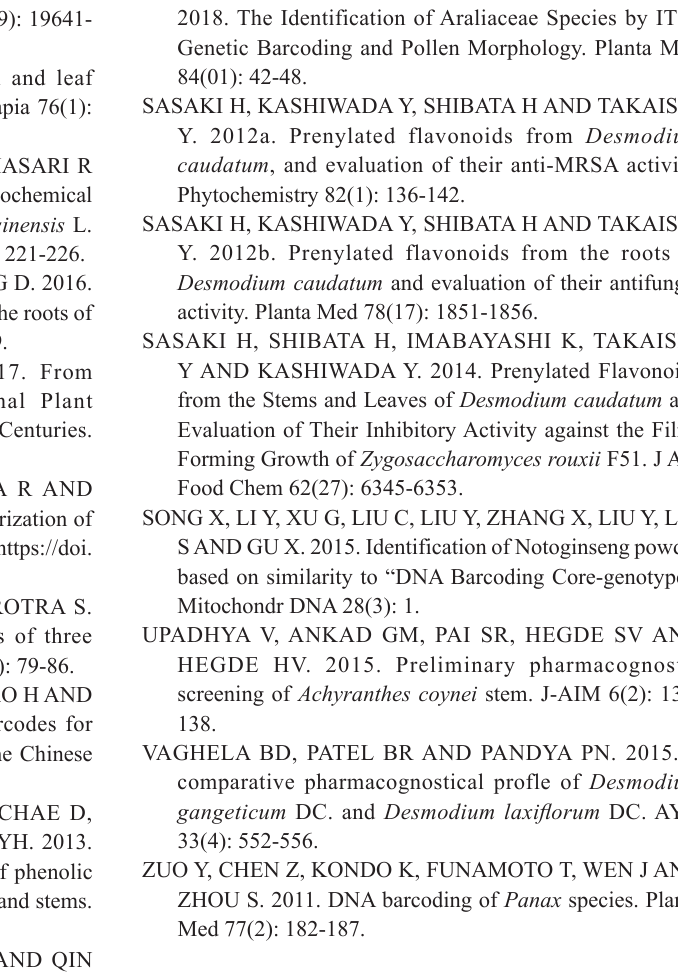
Figure S1 - Micrograph of leaf epidermis of Desmodium caudatum, A represents the upper epidermis, whereas B is the lower epidermis. Bars: A= 50 µm, B= 30 µm. Figure S2 - Microscopic powder features of Desmodium caudatum. PC: parenchyma cell; Fi: fibre; SV: spiral vessels; PV: pitted vessel; GH: glandular hairs; NGH: nonglandular hair; SC: solitary crystal; PG: pollen grain. Bars: 50 µm. Figure S3 - TLC chromatogram of Desmodium caudatum. (1, 2, 3: Sample solution; 4: the Reference